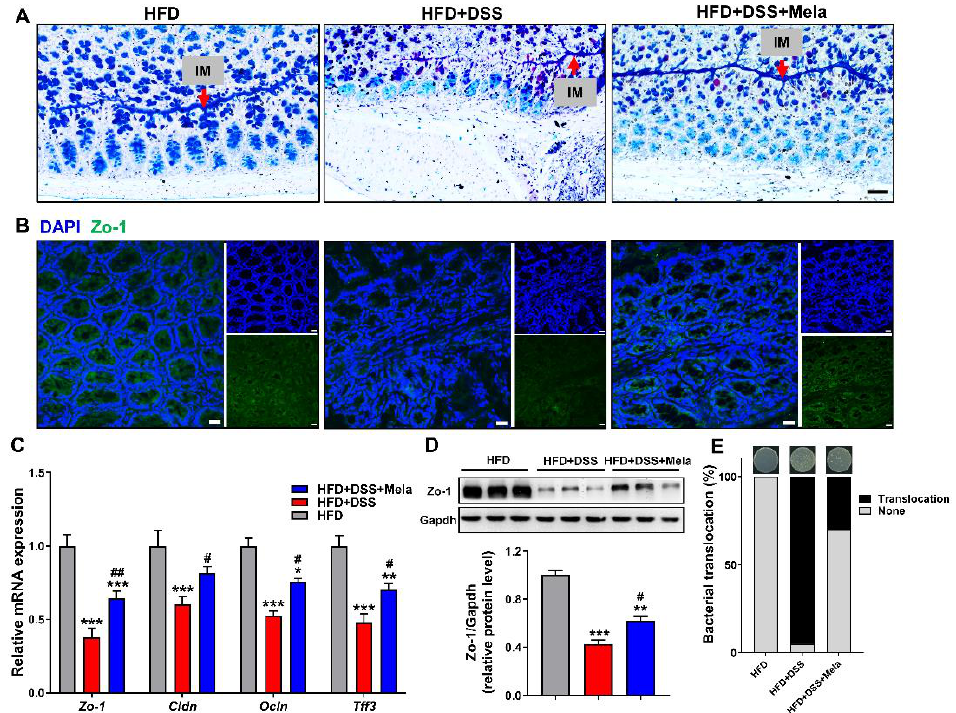
Figure 5. Melatonin reverses intestinal barrier integrity in DSS-treated obese mice. ( A ) Representative AB-PAS-stained colonic sections. Acid mucins: blue. Mixtures of acidic and neutral mucins: purple. Nuclei: pale blue. IM, inner mucus layer. (Scale bar = 50 μm). ( B ) Immunofluorescence of Zo-1 ( green ) and DAPI ( blue ) in colon sections (Scale bar = 50 μm). ( C ) The mRNA expression of Zo-1 , Cldn , Ocln , and Tff3 in the colon. ( D ) Zo-1 protein levels were measured by Western blotting, ( E ) Incidence of bacterial translocation. The results are mean ± SEM. n = 10. * p < 0.05, ** p < 0.01, *** p < 0.001 compared with HFD; # p < 0.05, ## p < 0.01 versus HFD + DSS.